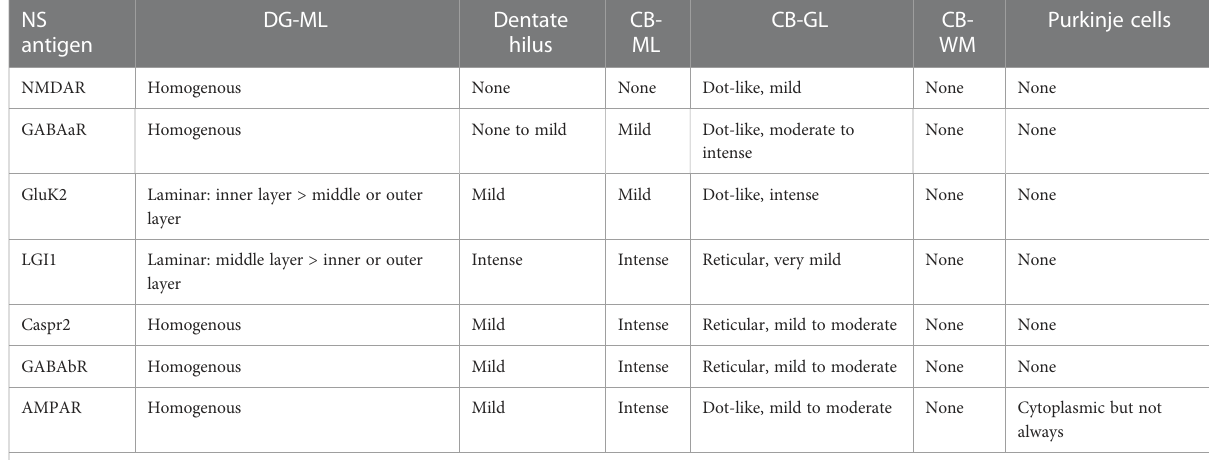
TABLE 1 Immunostaining pattern highly characteristic of major neuronal surface